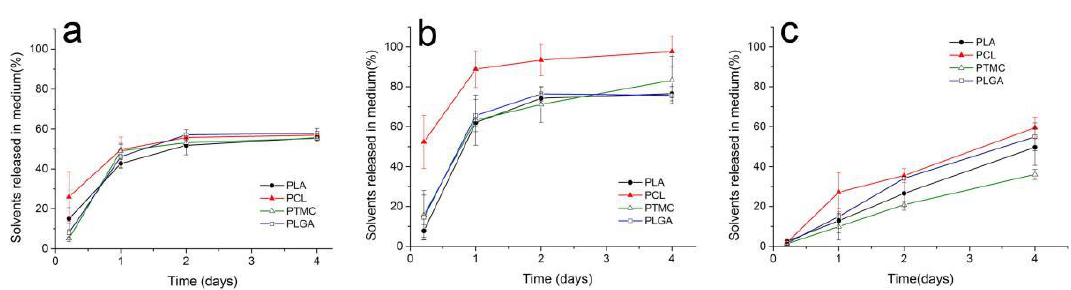
Figure 4. The removal rate of organic solvents ( a ) NMP, ( b ) DMSO and ( c ) TA from different polymer ISFIs. (mean ± S.D., n = 3).